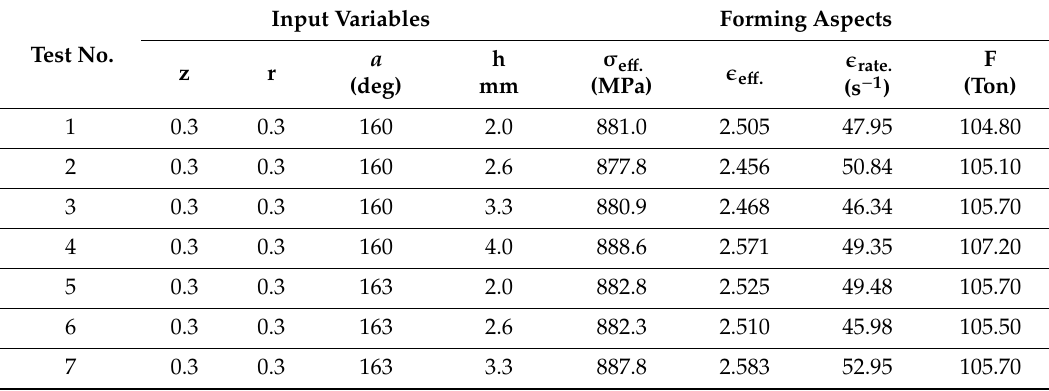
Table A1. FE simulation design combinations and the forming responses.